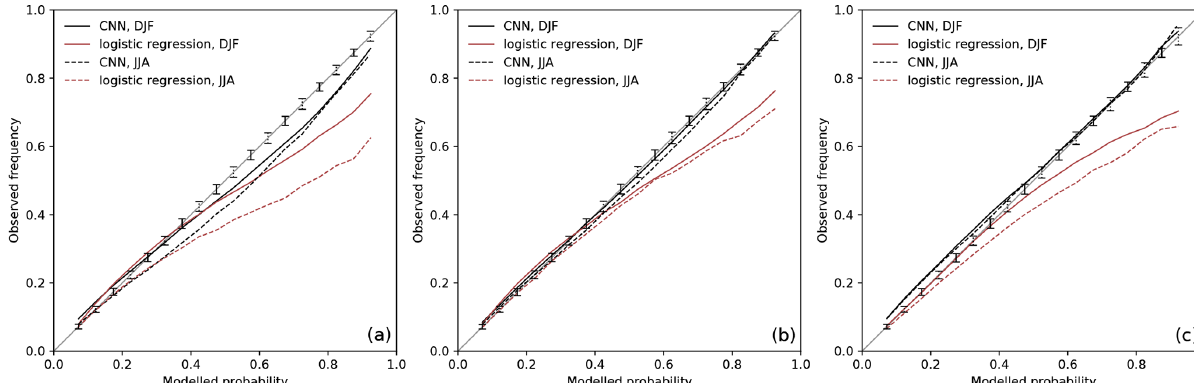
Figure 3. Reliability diagrams for (a) inflow, (b) ascent, and (c) outflow during DJF (solid lines) and JJA (dashed lines). The black curves represent the reliability of the CNN models, and the red curves represent the reliability of the logistic regression models (Quinting and Grams, 2021b). Modeled probabilities ( x axis) and observed frequencies ( y axis) are binned into 19 bins based on the modeled probabilities. The range between the 5% and 95% quantiles of the consistency resampling is given for DJF and JJA by solid and dashed vertical bars,